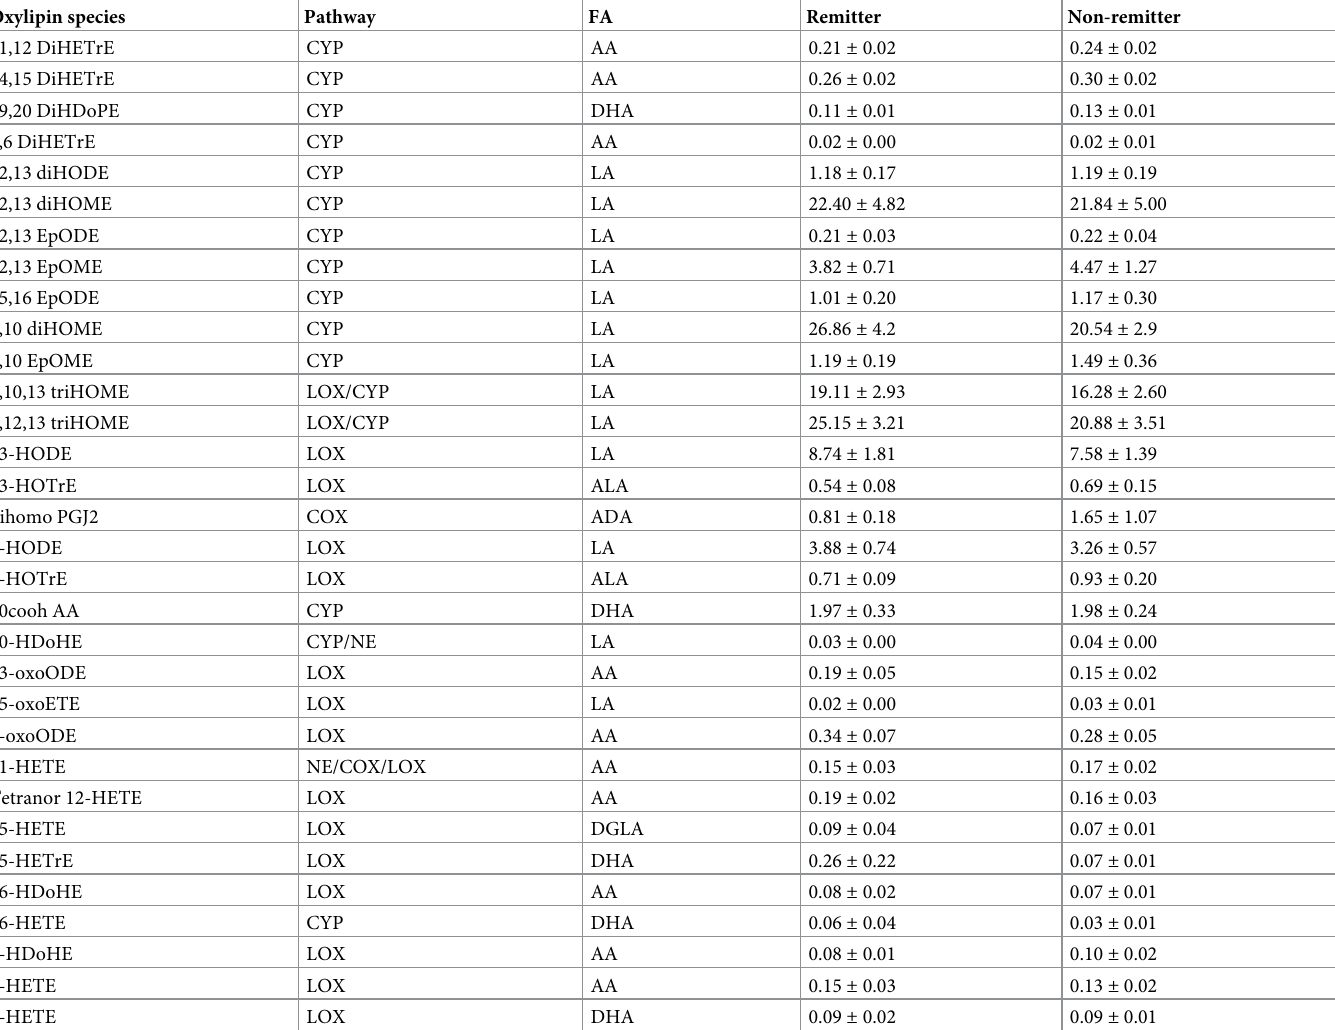
Table 2. Mean values [ ± SEM] of all oxylipin species [ng/ul] identified in remitters [n = 21] and non-remitters [n = 25] before rTMS treatment. Oxylipin